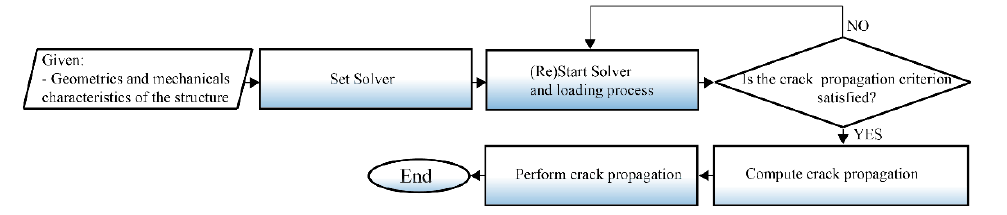
Figure 3. Synoptic representation of the proposed algorithm.